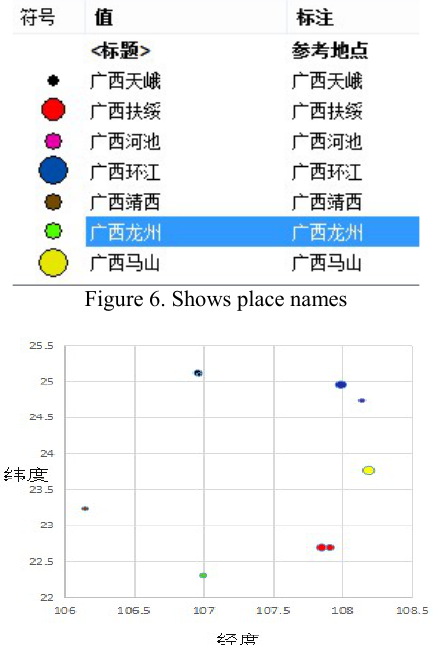
Figure 7. Seismic source scatter diagram